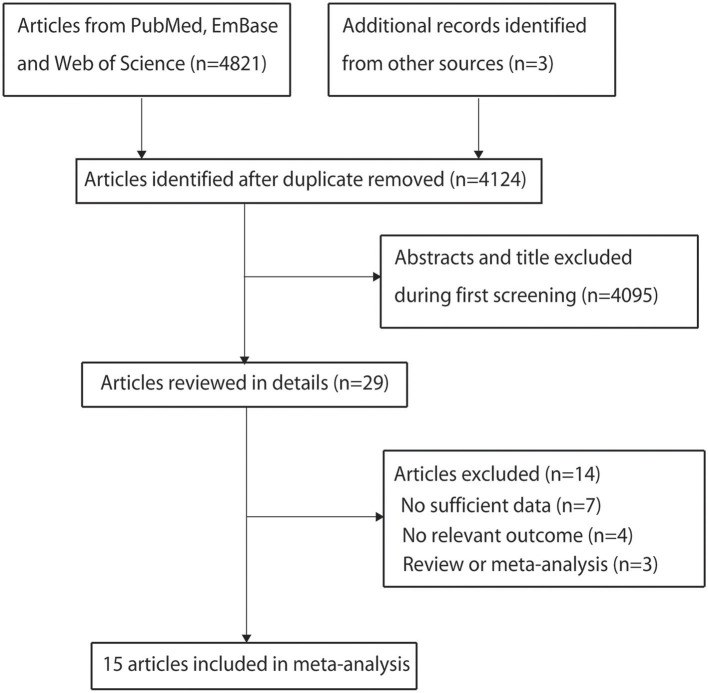
Flowchart of the selection of studies included in the meta-analysis.